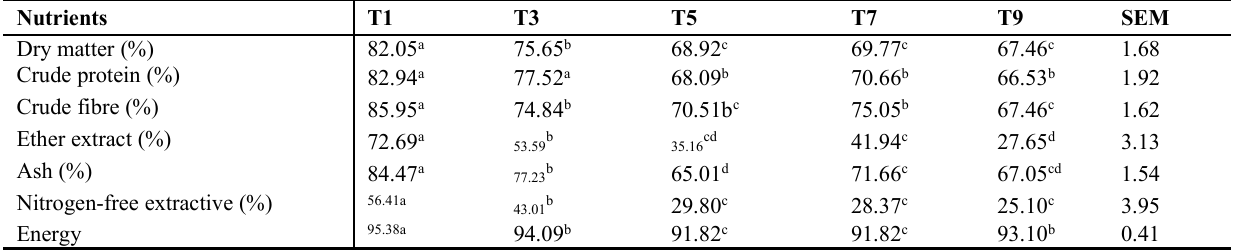
a, b, c, and d means within rows with similar superscripts are not significantly different (p>0.05), SEM= Standard error of mean, NFE = Nitrogen-free